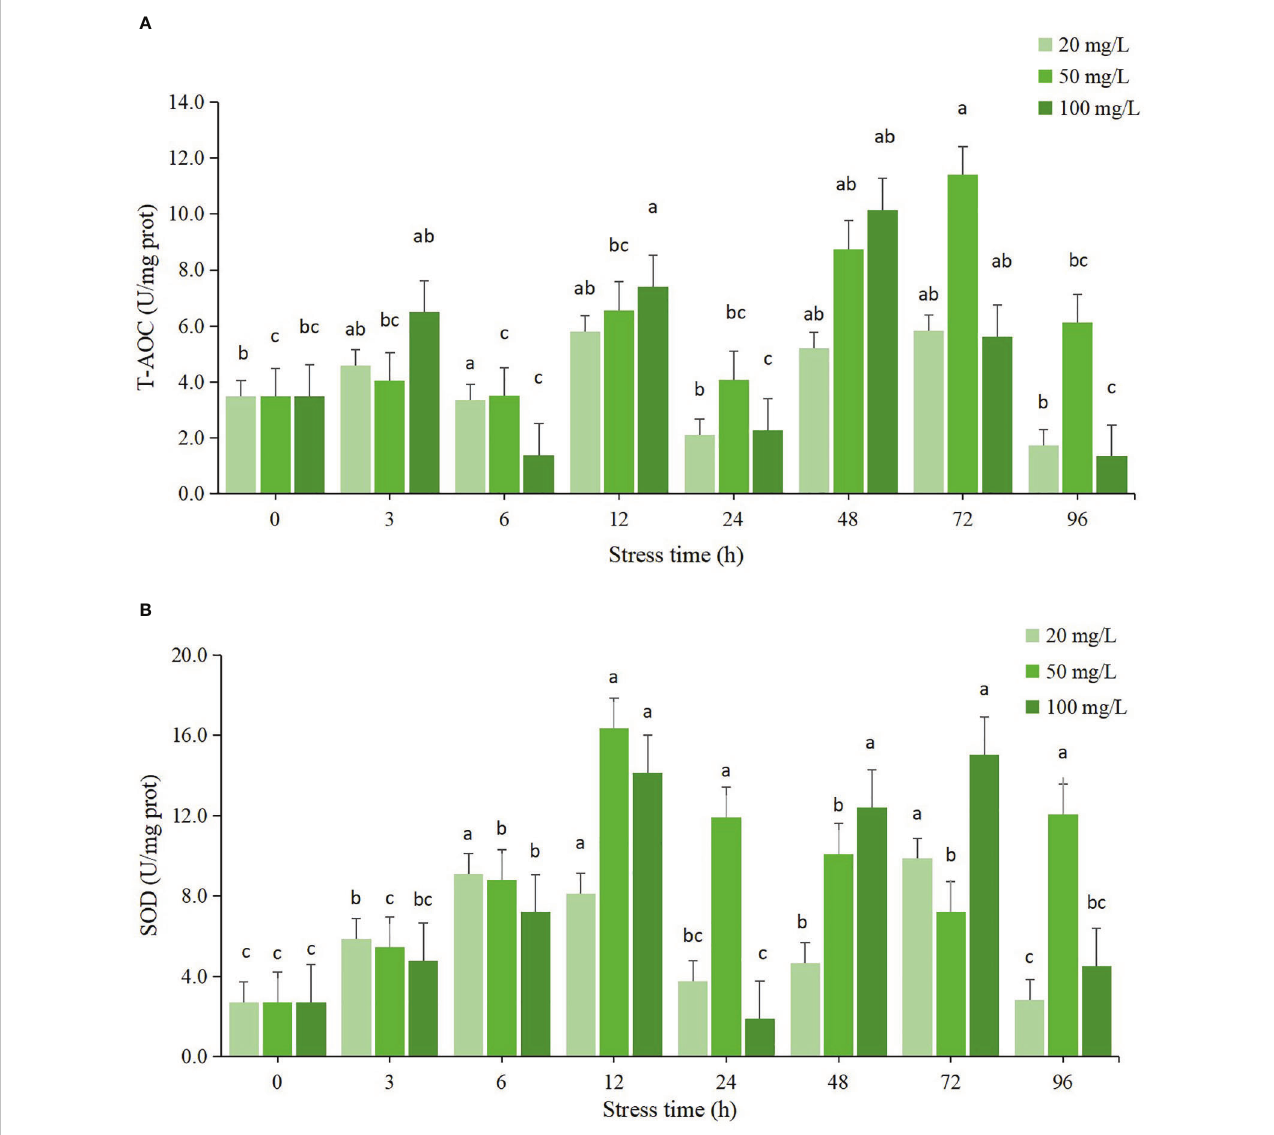
FIGURE 2 Changes of antioxidant enzyme activities in hepatopancreas of C sinensis at different time points after different residual chlorine stress. (A) T-AOC activitiy, (B) SOD activitiy. Different letters indicate statistically signi fi cant differences between different time points for the same treatment using one-way ANOVA and Tukey ’ s comparison of the means test ( P <